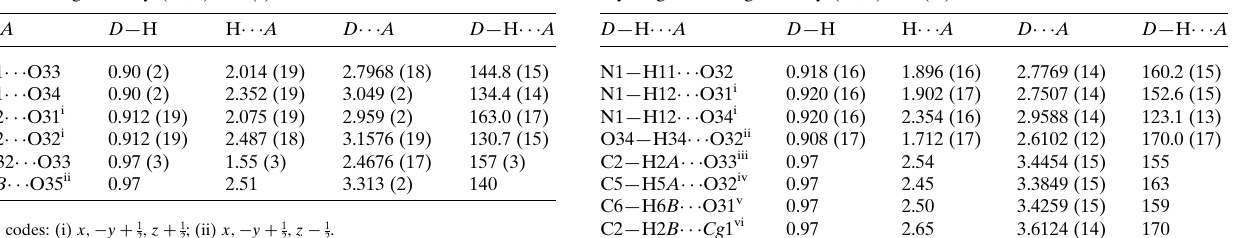
Table 1 Hydrogen-bond geometry (A˚ , (cid:4) ) for (I).